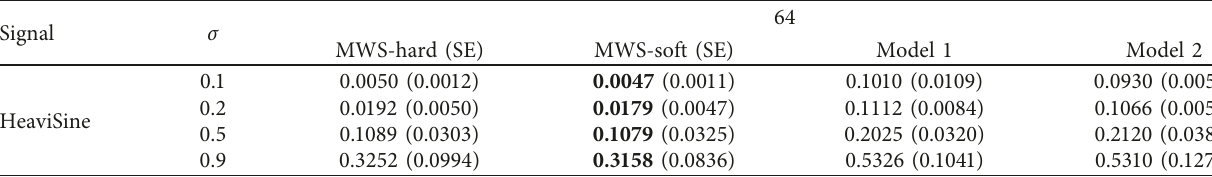
Figure 9: The wavelets function for Daubechies’ wavelet N � 3 (a) and complex Daubechies’ wavelet equivalent (b). The real part is drawn as a solid black line and the imaginary wavelet coefficients as a solid red. Table 1: Comparison of nondecimated complex wavelet shrinkage methods for 64 wavelet coefficients: CMWS-hard and CMWS-soft. Results are AMSE and standard errors replicated 1000 for estimation of standard test functions. The bold font indicates the smallest AMSE